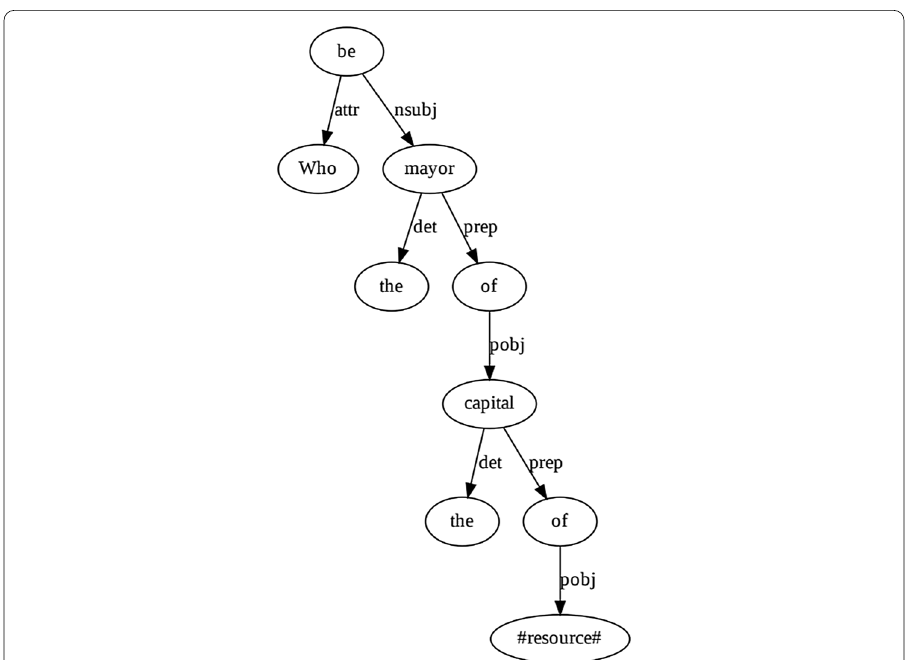
Fig. 2 Lemma expressions and dependency parse tree annotated with dependency labels for the question: “Who is the mayor of the capital of French